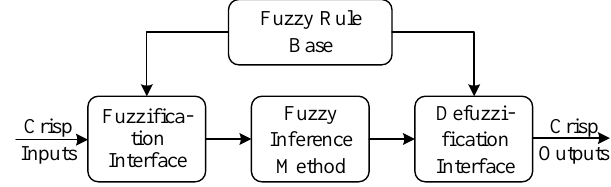
Figure 1. Structure of a fuzzy inference system.